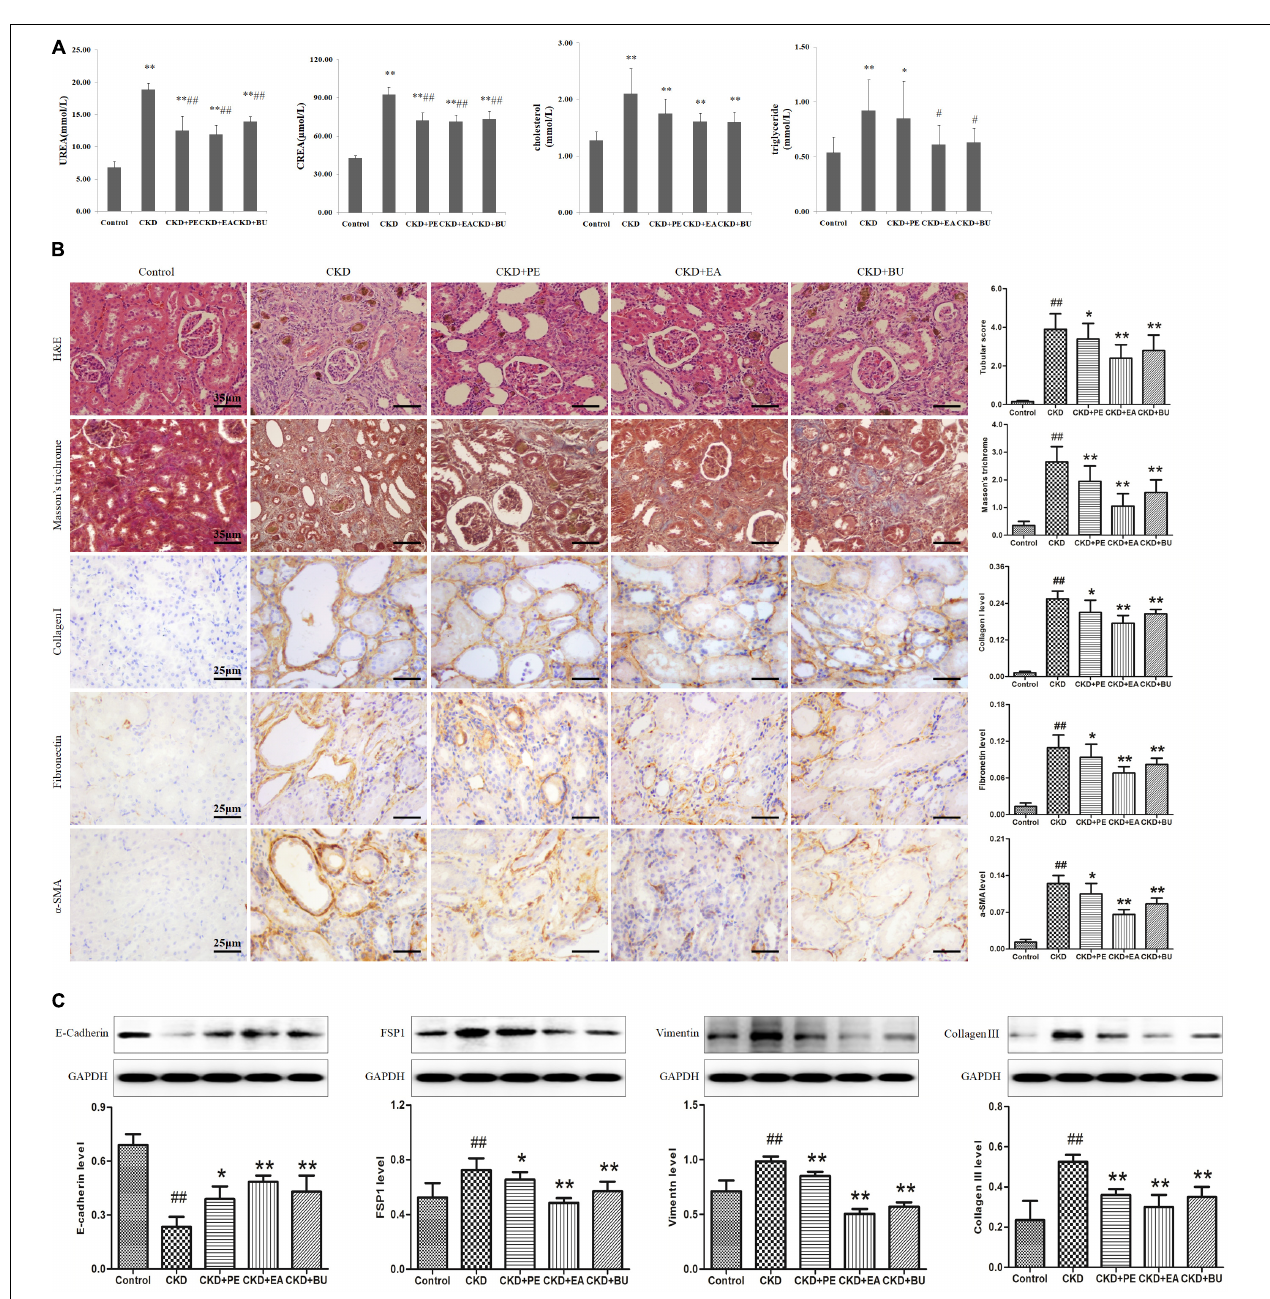
FIGURE 1 | (A) Biochemical parameters including cholesterol, triglyceride, creatinine (CREA), urea in the normal control, CKD+PE, CKD+EA, and CKD+BU groups. (B) Representative photomicrographs of the H&E staining, Masson’s trichrome staining, collagen I, Fibronectin, and α -SMA immunohistochemistry from kidney sections in control, CKD, CKD+ PE, CKD+ EA, and CKD+ BU groups. (C) Renal fibrotic protein expression in the five different groups. Expression levels of E-cadherin, FSP1, vimentin, and collagen III proteins were determined in control, CKD, CKD+ PE, CKD+ EA, and CKD+ BU groups by Western blotting. Bar graphs depicted expression intensity of E-cadherin, FSP1, vimentin, and collagen III proteins. GAPDH served as the loading control. ## p < 0.01 compared to controls; ∗ p < 0.05, ∗∗ p < 0.01 compared to CKD